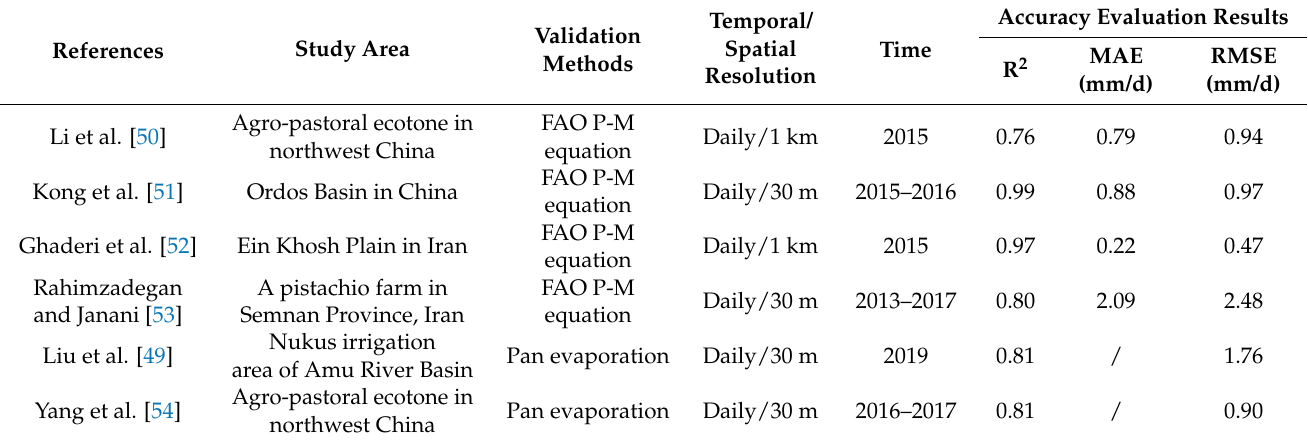
Table 4. Validation results of SEBAL ET in previous